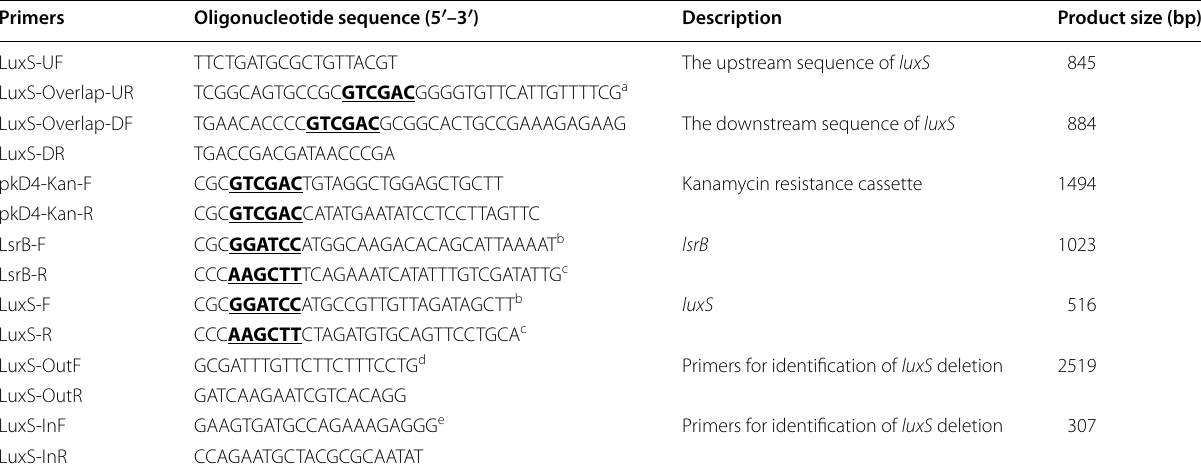
a, b, c Sal I, Bam HI and Hin dIII restriction sites are underlined, respectively d A 307 bp PCR product was amplified from wild-type strain BL21(DE3), and no product was amplified from mutant strain BL21Δ luxS , using primers LuxS-inF/LuxS-inR e A 2519 or 2209 bp PCR product was amplified from wild-type strain BL21(DE3), or mutant strain BL21Δ luxS without kan, respectively, using primers LuxS-OutF/LuxS- OutR